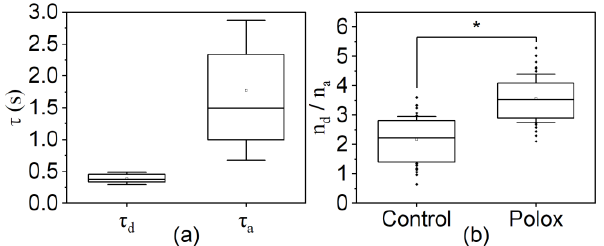
Figure 3. The addition of Poloxamer 188 reduced aggregation. ( a ) The time constants of RBC diso- rientation τ d and aggregation τ a measured via PPG on whole blood. ( b ) The disorientation-to-aggre- gation-constant ratio n d /n a of whole blood (Control) and of whole blood with Poloxamer 188 (Polox). Box: 25% – 75% range, whiskers: mean ± SD, * p ≤ 0.001.